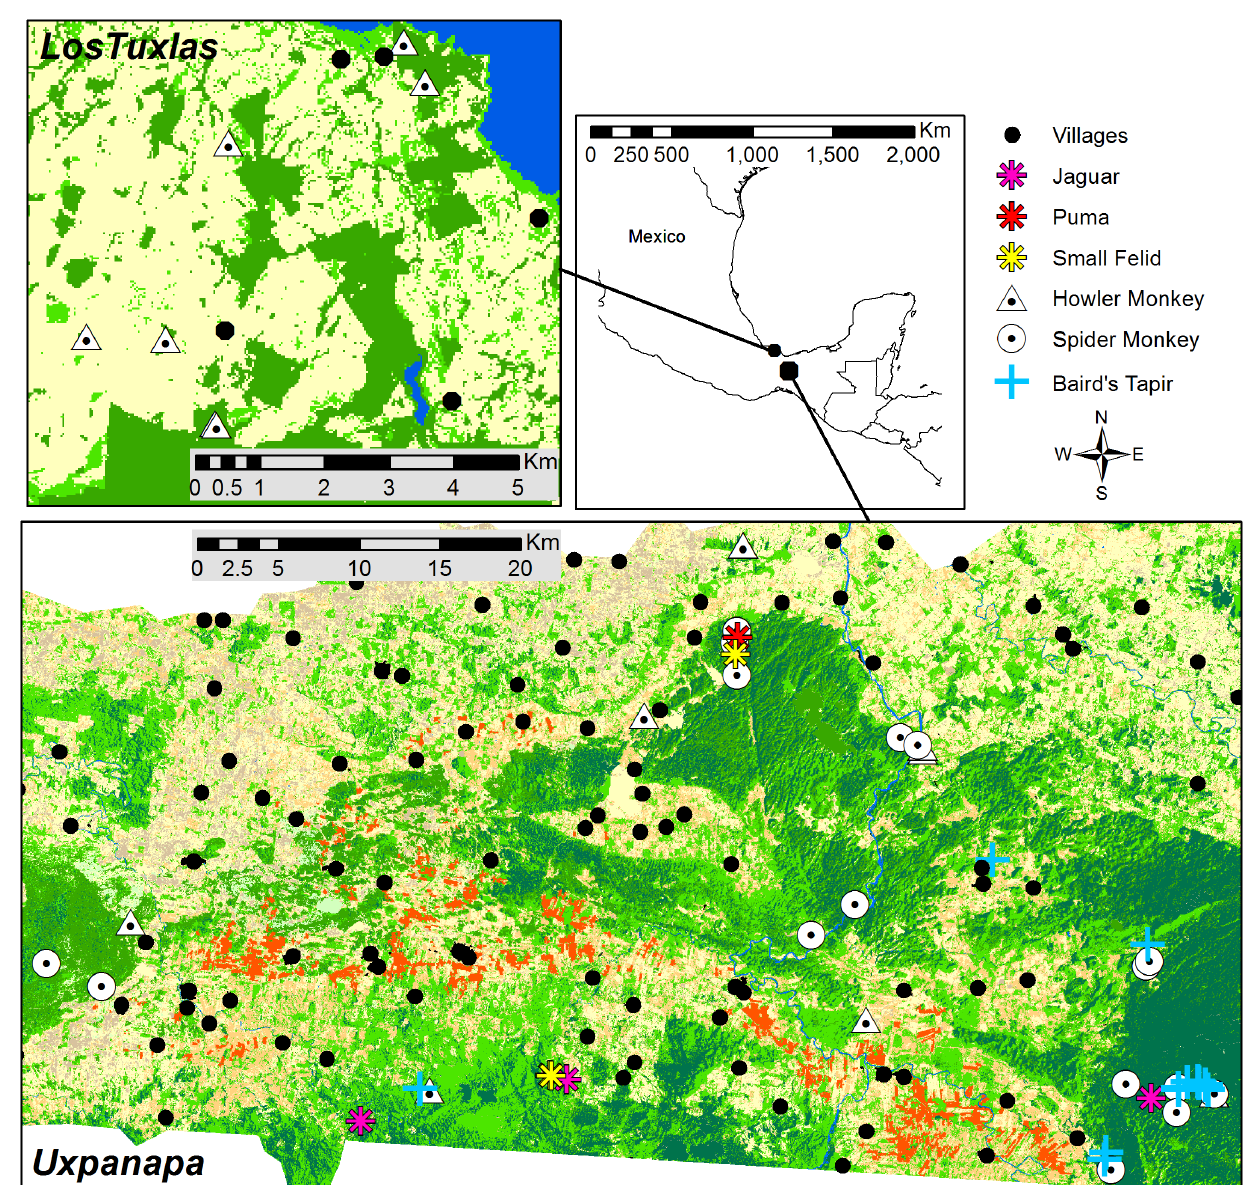
Figure 1. Map showing the locations of fecal samples collected from primates, felids and tapirs in two study sites (Los Tuxtlas and Uxpanapa) in south-east Mexico. Villages are indicated with black dots. Dark green represents mature forest, light green secondary forest, yellow pasture, light brown citric plantations, and red rubber plantations. Los Tuxtlas supervised classification map based on freely available Landsat 2011 images (source: usgs.gov). Uxpanapa supervised classification map based on SPOT5 scenes obtained from ERMEX/SEMAR (2010; source: ERMEXS, Estacio´n de Recepcio´n Me´xico de la Constelacio´n SPOT/Secretarı´a de Marina Armada de Me´xico. 2010. SPOT5 images).